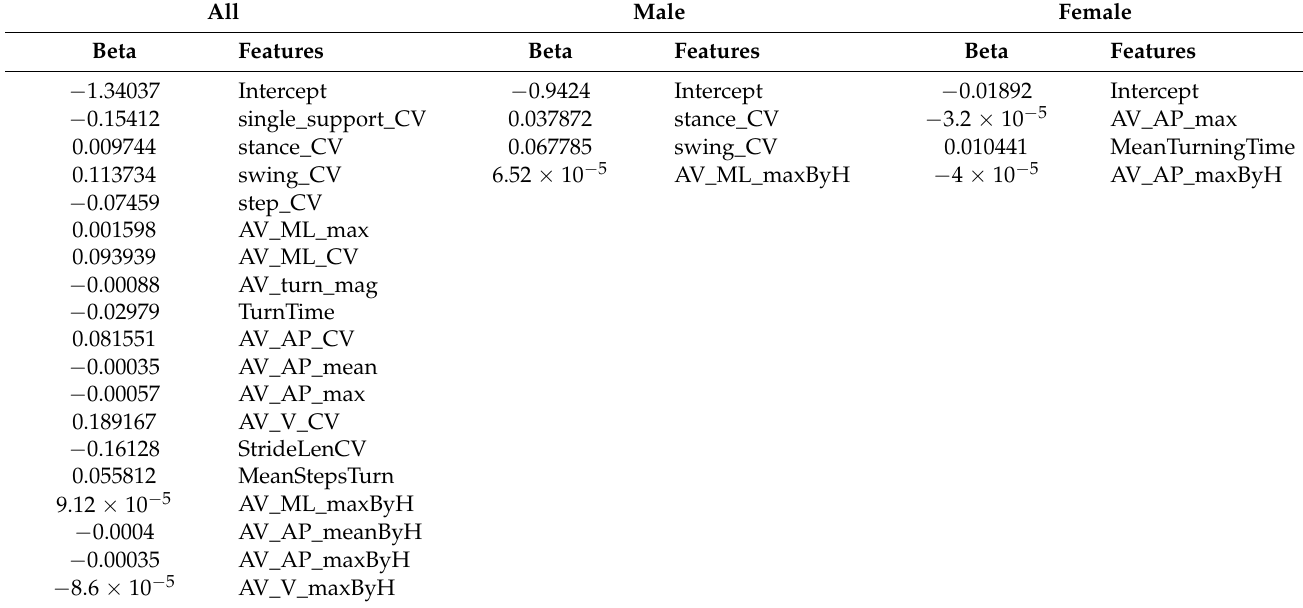
Table A8. TD-PD falls count model coefficients. Beta refers to Poisson regression coefficients, chosen through an elastic net